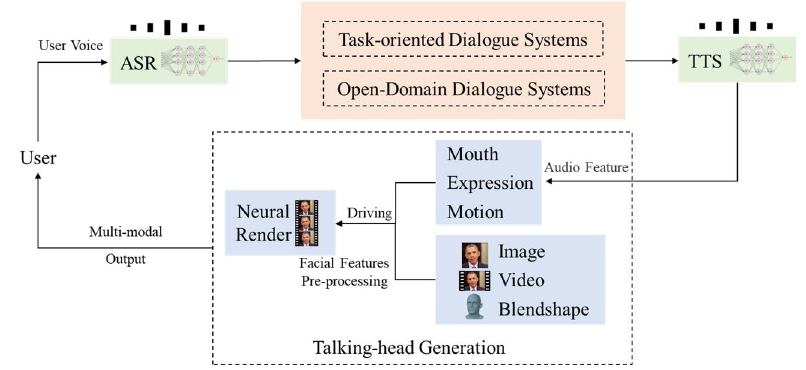
Figure 3 The system architecture of multimodal human–computer